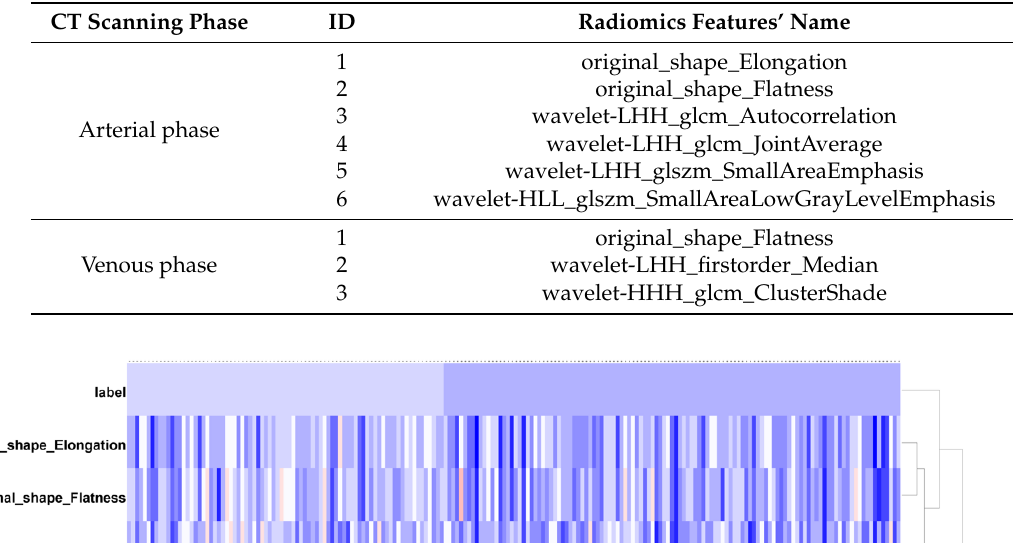
Table 2. Radiomics features’ selection results.